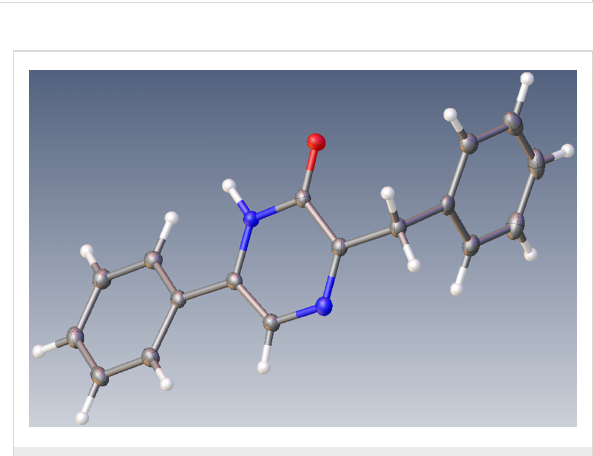
Figure 1: ORTEP depiction of compound 4